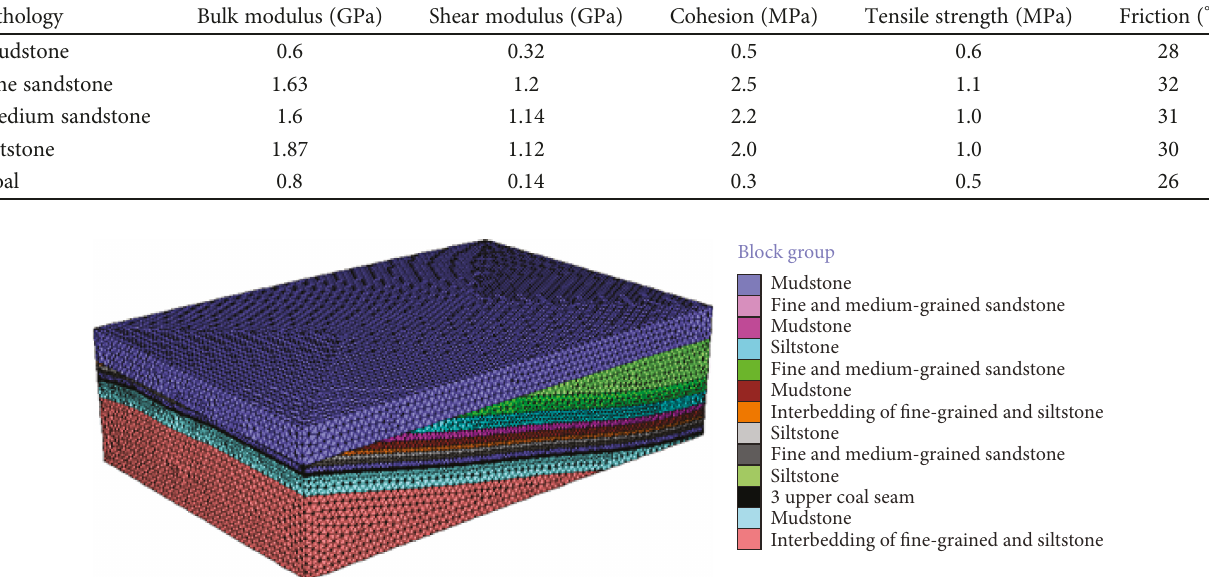
Table 1: Mechanical parameters of the main strata.